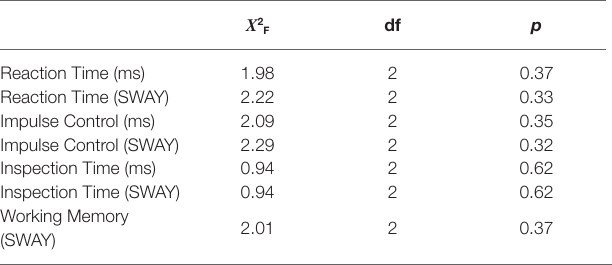
TABLE 2 | Friedman’s ANOVA Results.